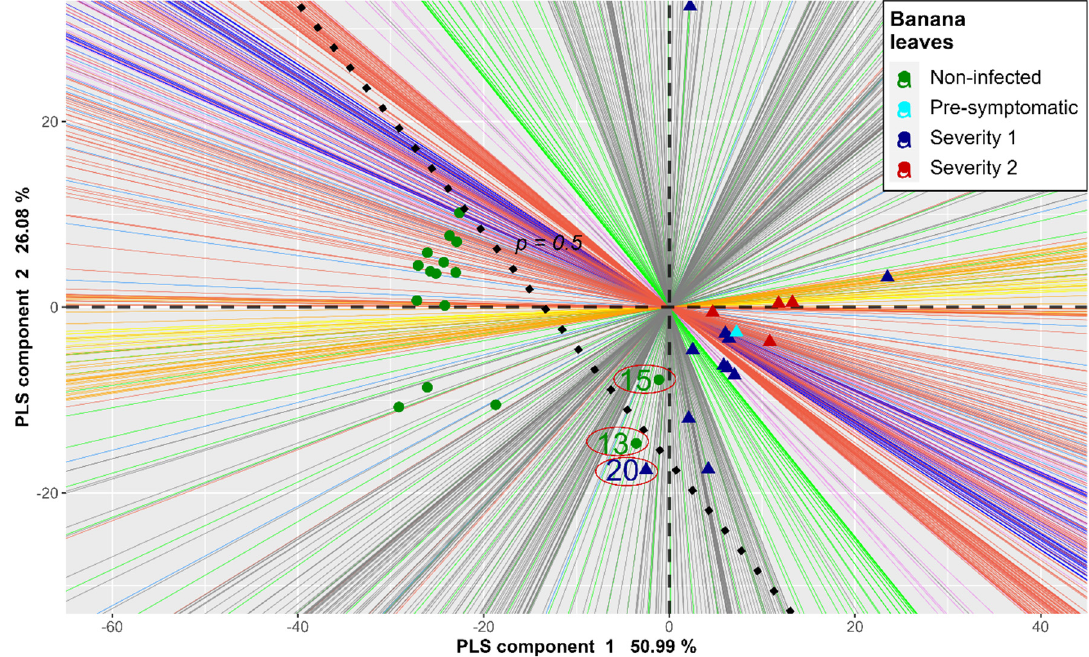
Figure 6. HS-Biplot of validation dataset highlighting misclassified